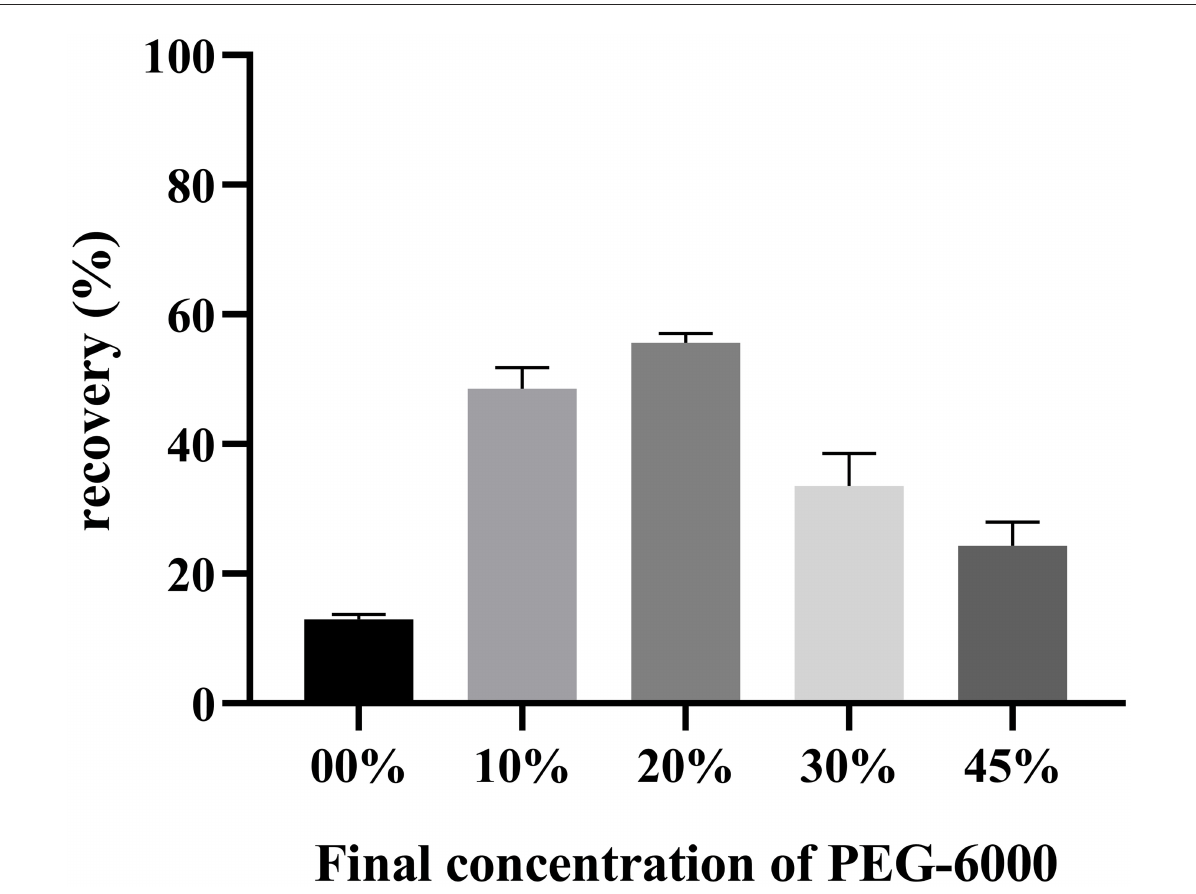
FIGURE5 Different final concentrations of PEG-6000 was added to the ASFV-containing eluate for determination viral recovery. After precipitation and centrifugation, the volume of liquid was reduced from 10ml to 0.4ml. More than 50.42 ( ± 4.53)% of the virus was recovered using the 20% PEG-6000